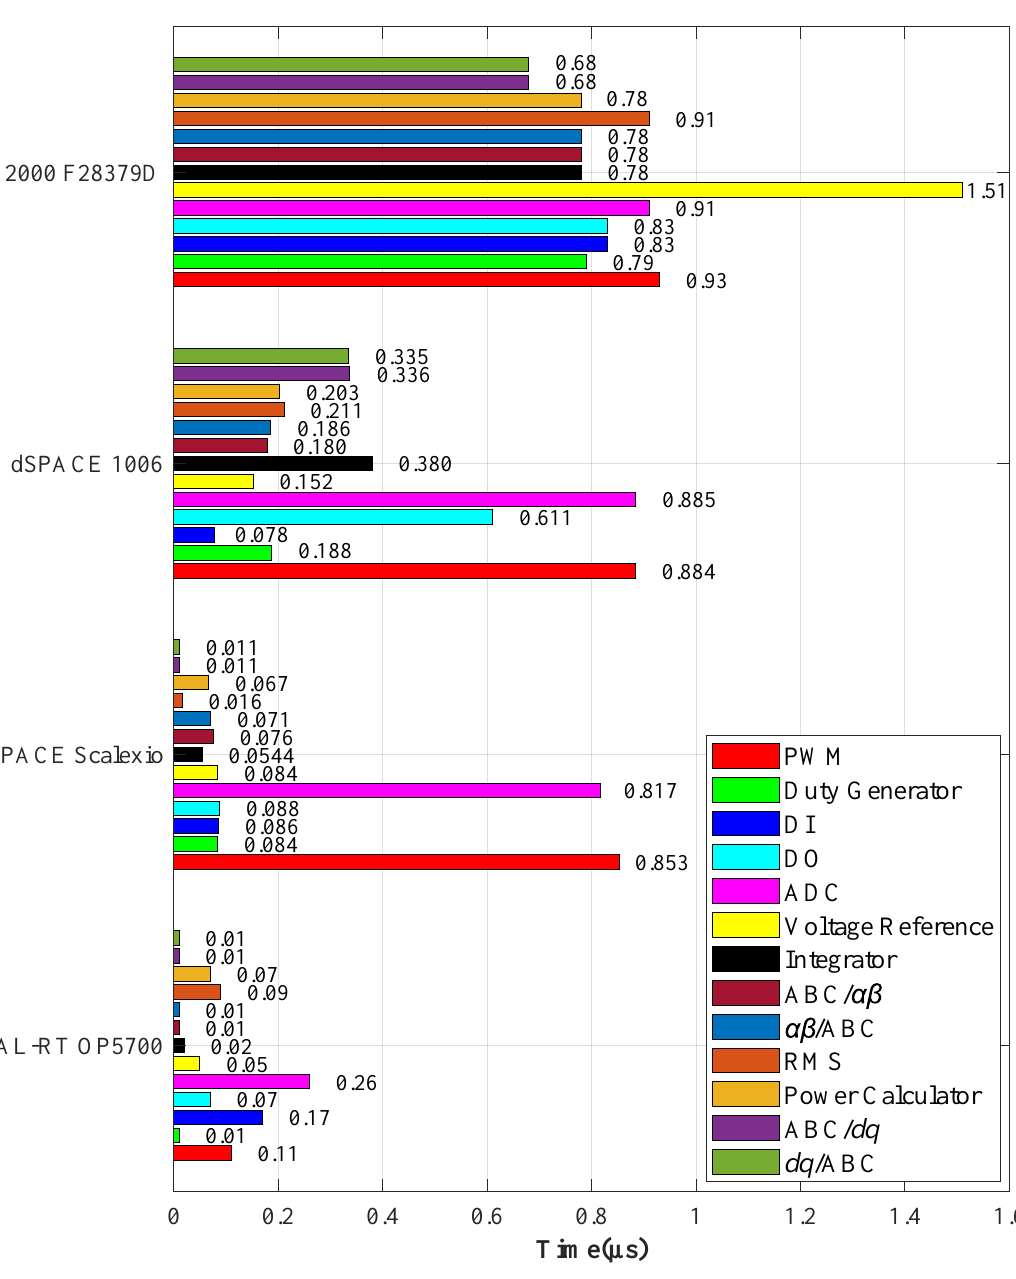
Figure 11. Computation time profile of each block in each